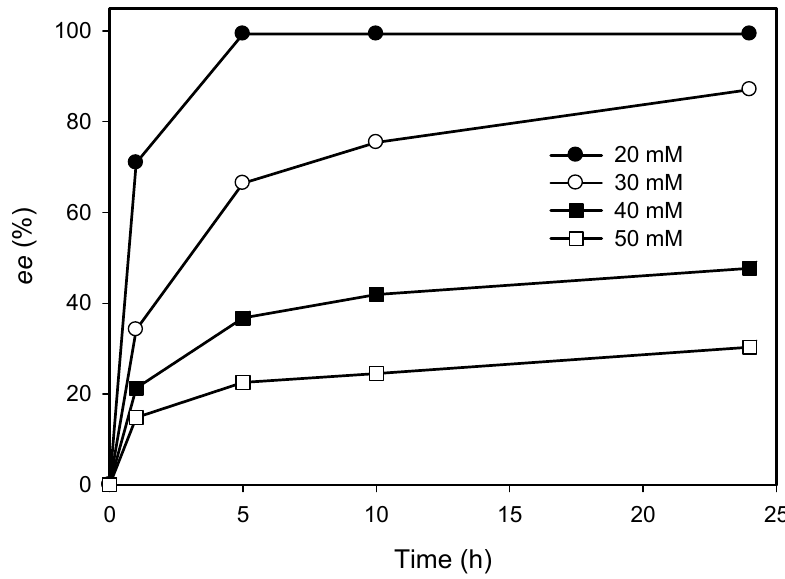
Figure 7. Reaction profiles of the kinetic resolution at different concentrations of a12 . Reaction conditions: a12 (0–50 mM), 100 mM Tris/HCl buffer (pH 8.5), whole-cell (25 mg dry cell weight (DCW)/mL).